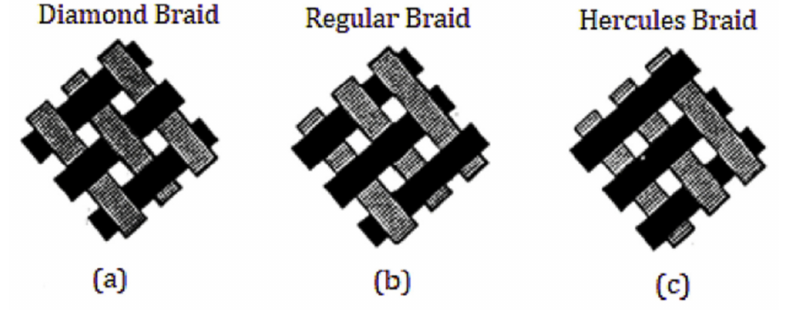
Figure 19. Braid support material with ( a ) Diamond ( b ) Regular and ( c ) Hercules pattern [15]. Reprinted/adapted with permission from Ref. [15]. Copyright 2022,